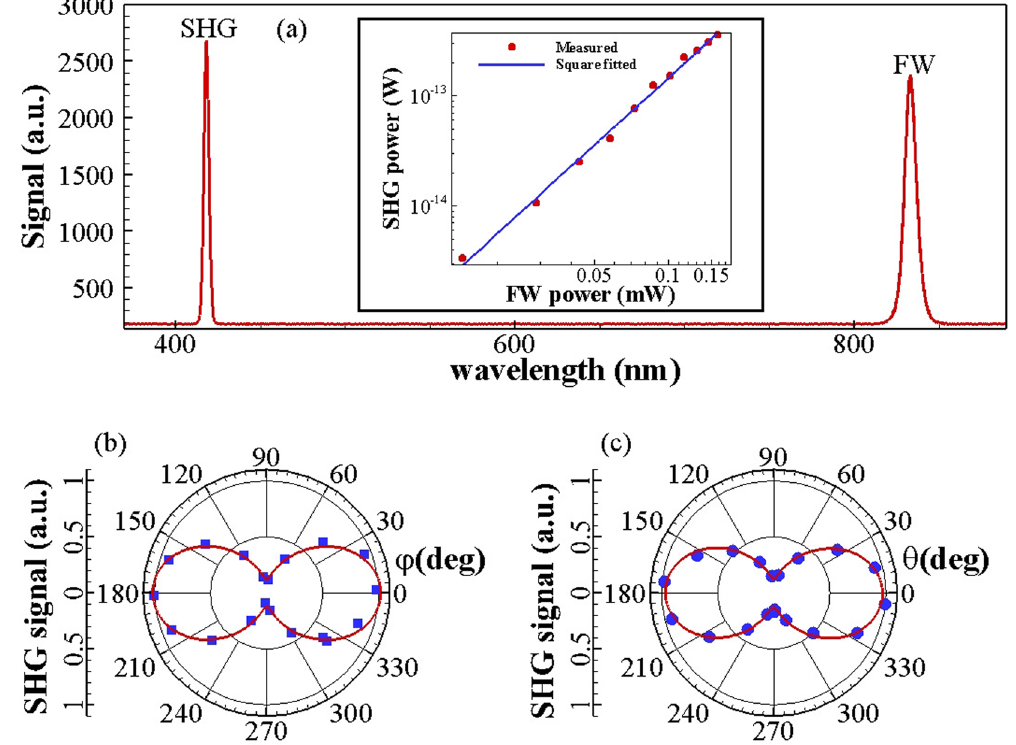
Figure 2. ( a ) Spectra of the excited SHG and the FW laser at a FW laser power of 87.12 μ W. The inset shows that the SHG signal has a square power dependence on the FW laser. ( b ) Polarimetric plot of the total SHG signal under parallel polarized excitation (TM). ( c ) Total SHG signal as a function of the FW polarization angle.